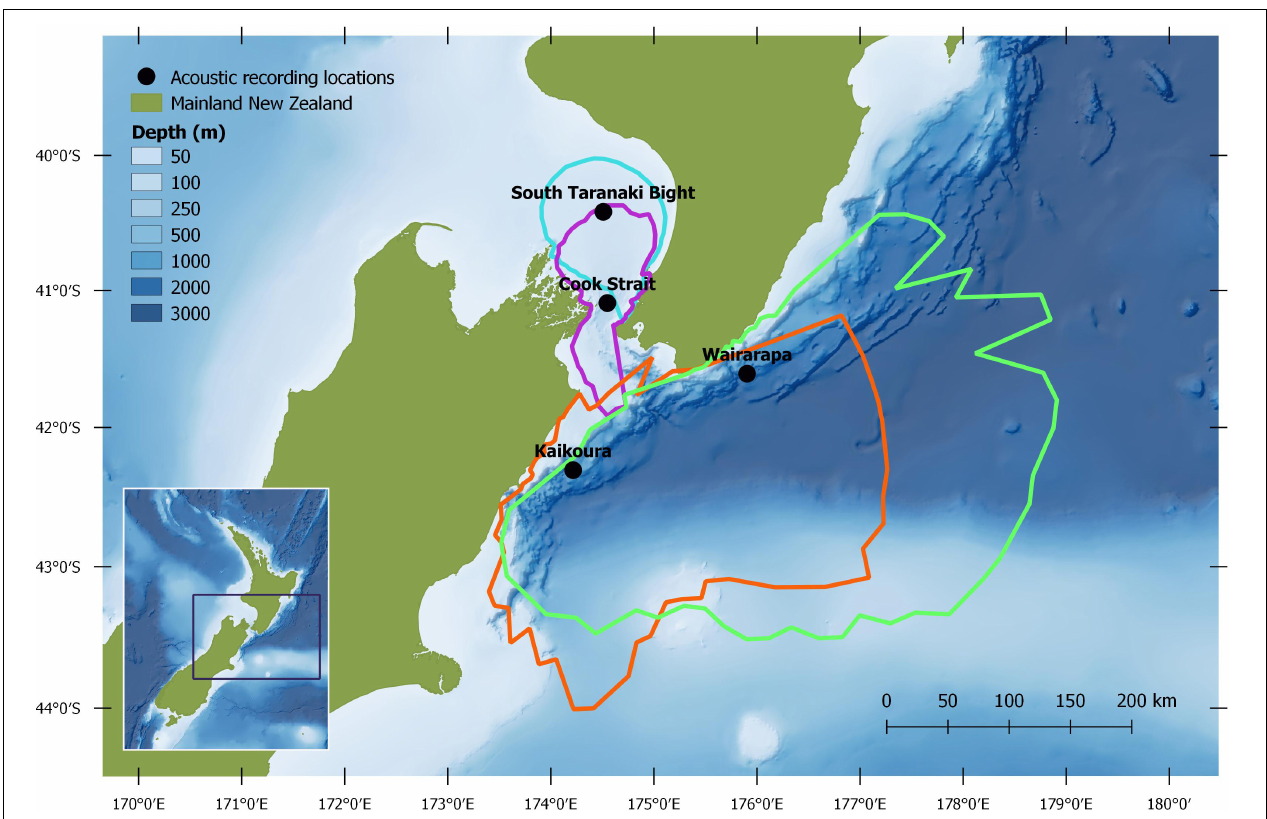
FIGURE 1 | Study region, with median modelled Antarctic blue whale detection areas for June 2016: turquoise = South Taranaki Bight, purple = Cook Strait, green = Wairarapa, orange = Kaik¯oura. See Methodology for modelling configuration and